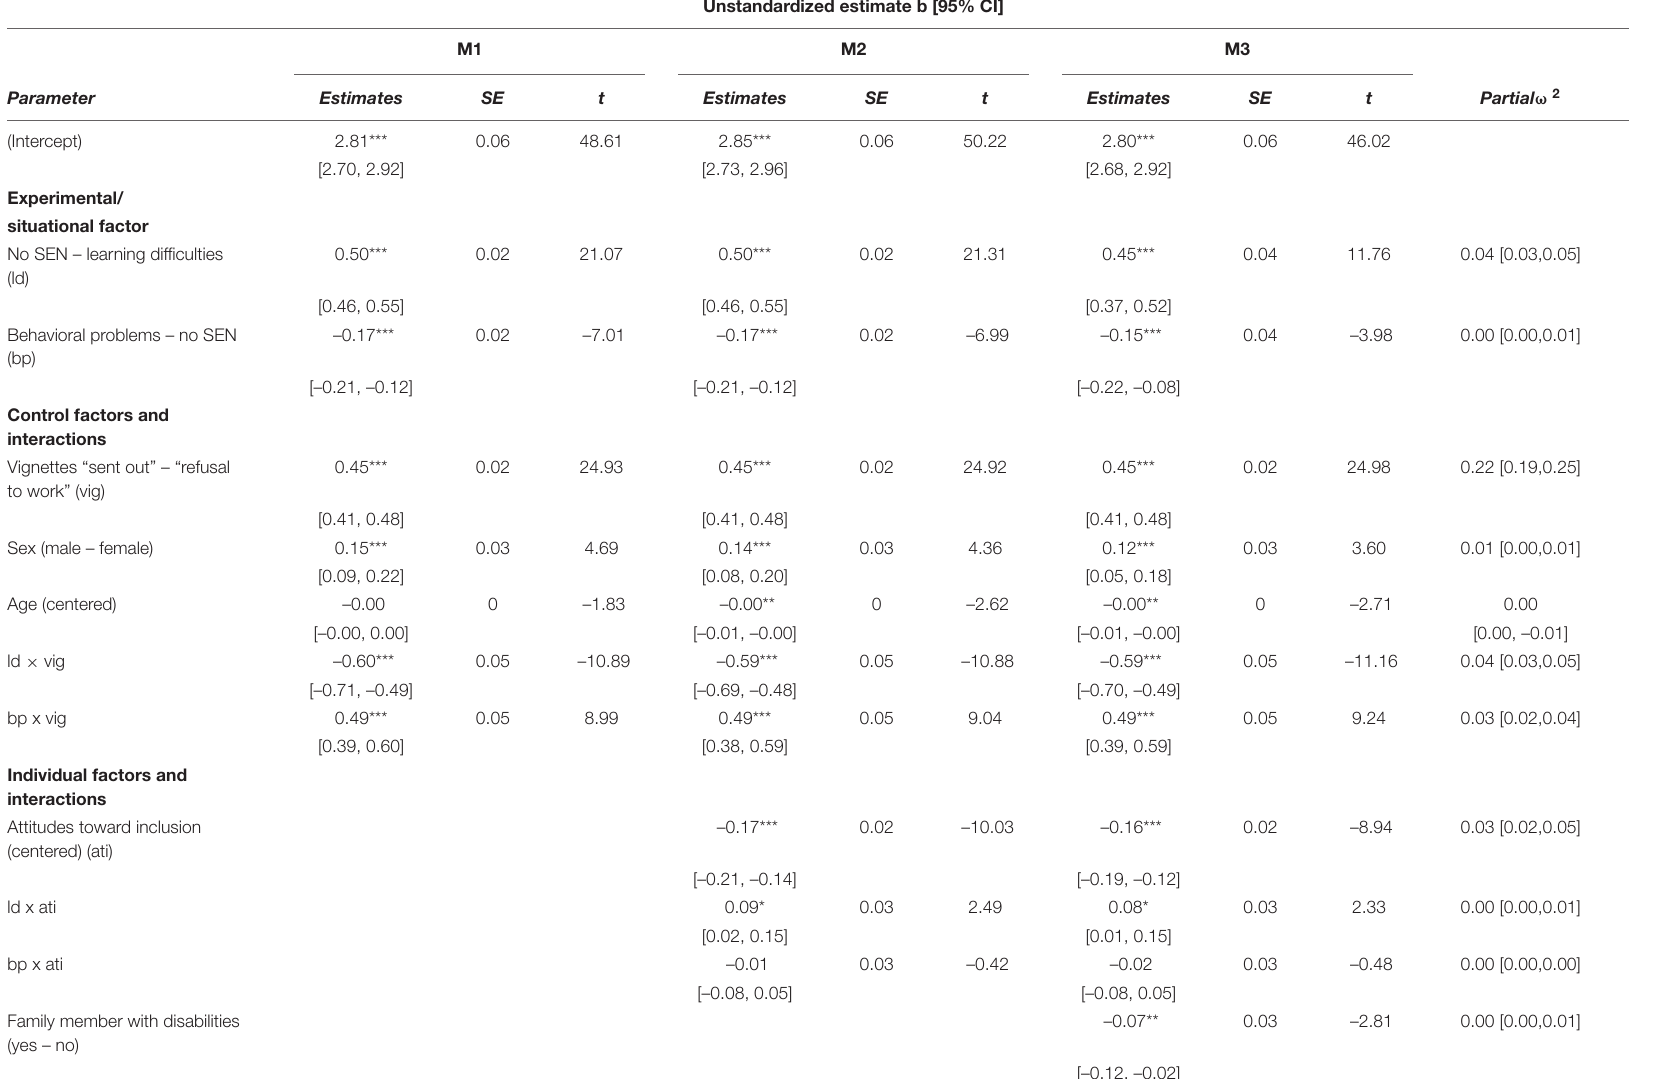
TABLE 3 | Fixed effects for mixed models predicting justice ratings of in-service teachers ( N =